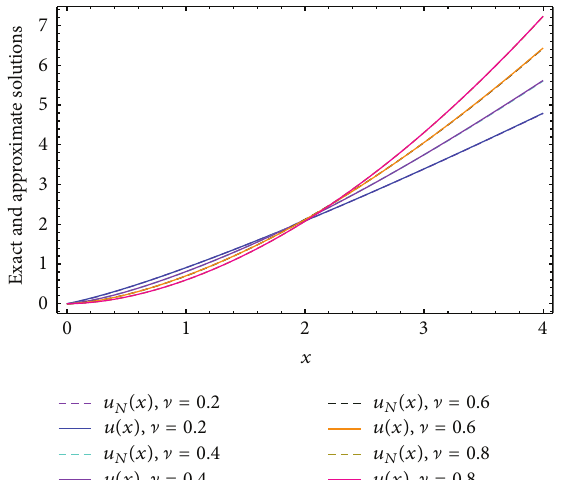
Figure 15: Comparing the exact and approximate solutions at 𝑁 = 16 , 𝛼 = 0 , 𝛽 = 1 , and ] = 0.2 , 0.4, 0.6, and 0.8.